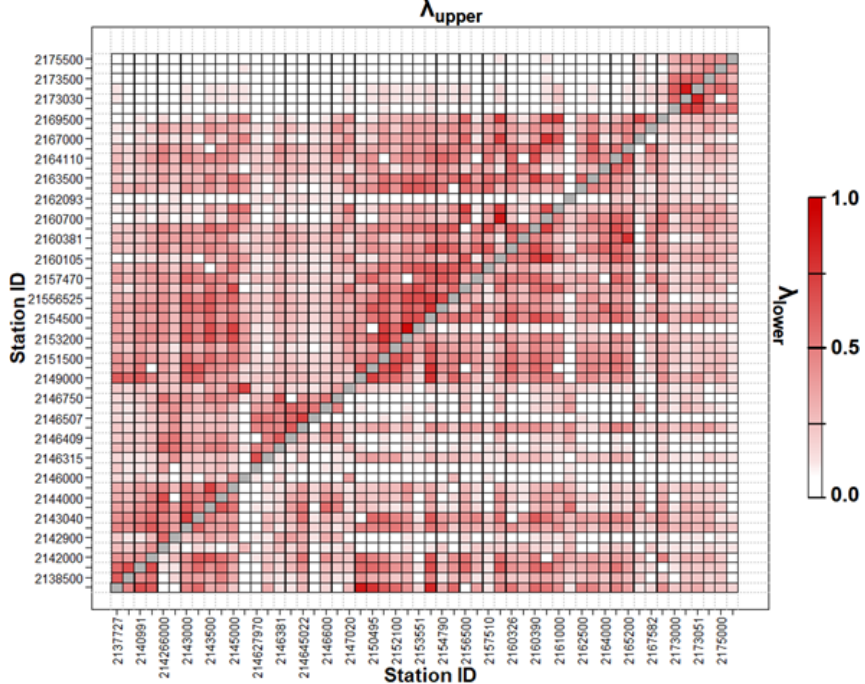
Figure 4. Pairwise upper- and lower-tail dependence for watersheds in the Yadkin–Pee Dee River basin. The upper triangular matrix shows values for the upper-tail dependence and the lower triangular matrix presents values for the lower-tail dependence. The metrics can range from 0 to 1, with higher values suggesting greater interdependence of the two streamflows for each upper- and lower